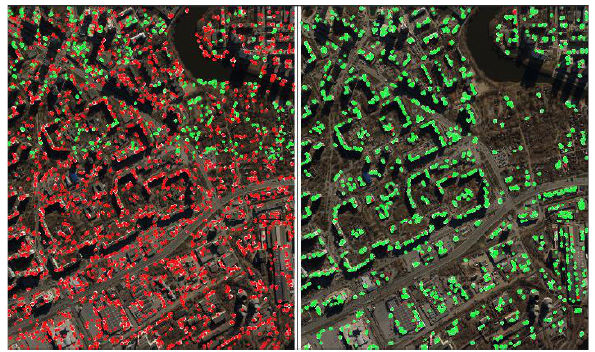
Figure 6 . Tie points on the image without masks (left) and with masks (right). The green dots are final points, the red ones are filtered and removed.